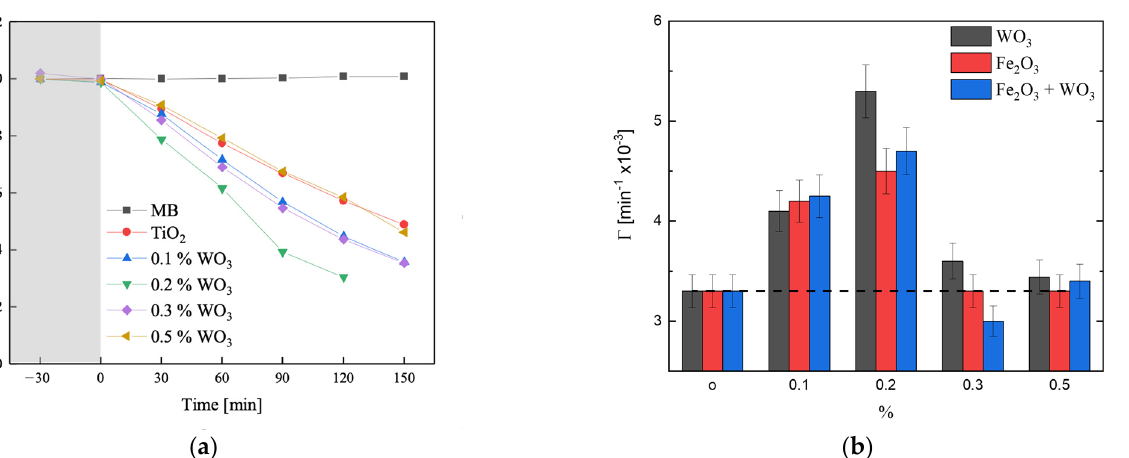
Figure 5. ( a ) Methylene blue photodegradation; ( b ) Histogram of photodegradation rate of nanocomposites as a function of concentration.